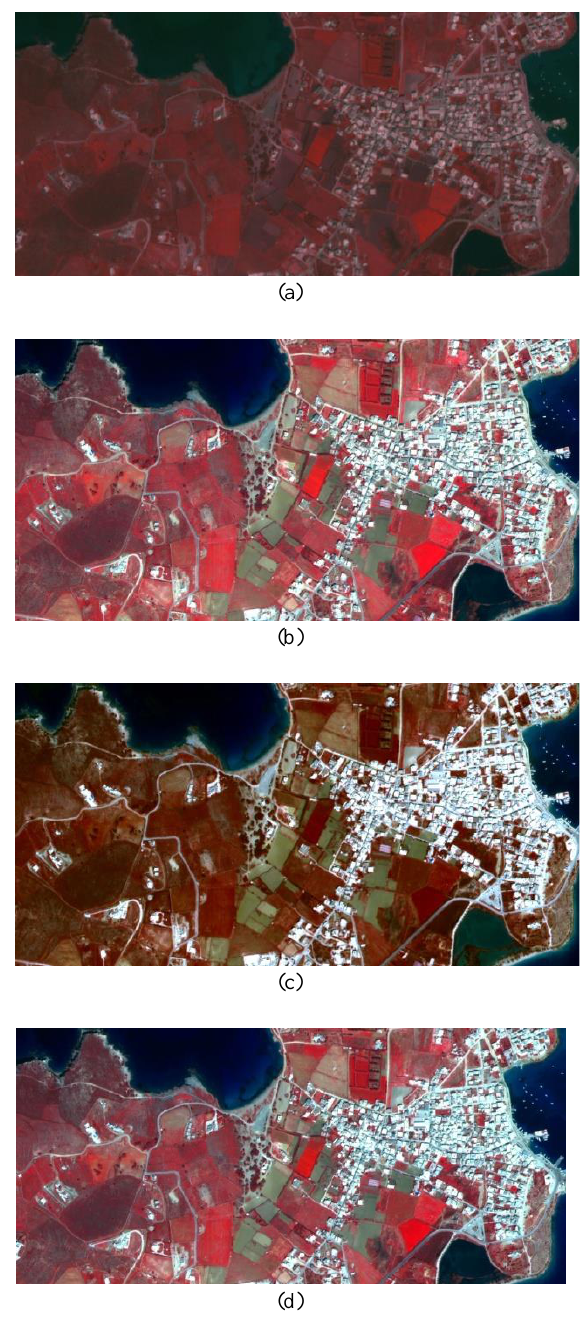
Figure 3: A zoom of the original MS image (a) and the Pansharpening results from IHS (b), Brovey (c) and PCA (d) algorithms for 4